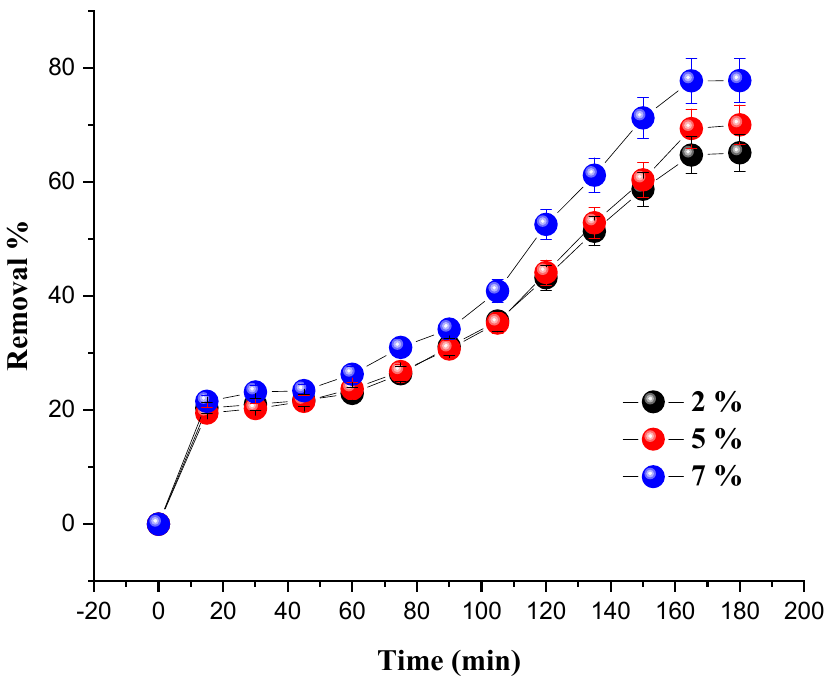
Figure 5. Effect of nickel loading on MG removal in terms of time. (Reaction conditions: C 0 = 20 mg/L, m = 0.2 g, V H2O2 = 10 mL, pH = 7 and T = 25 °C).